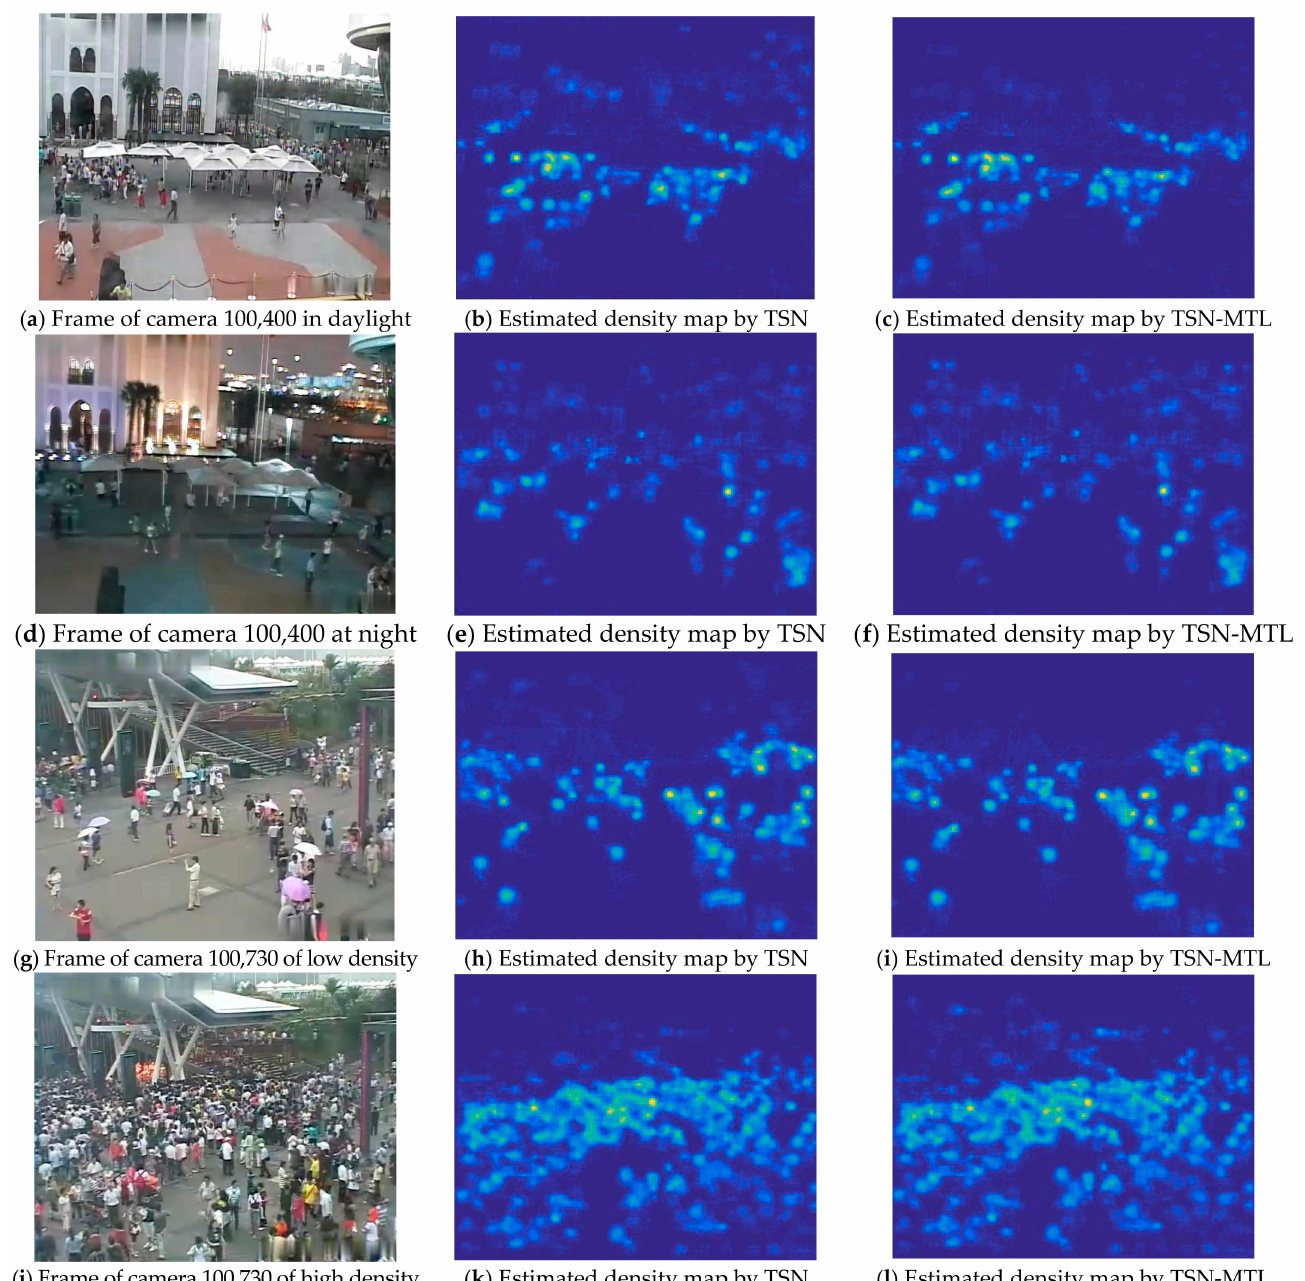
Figure 4. Robustness performance of the proposed TSN-MTL under different lighting conditions and crowd density. Display of estimated crowd density map of pictures collected by camera 100,400 and 100,730. The first column is the original picture, the second column is the density map estimated by STN and the third column is the density map estimated by STN with MTL. The first two rows are frames collected by camera 100,400, while the next two rows are frames collected by camera